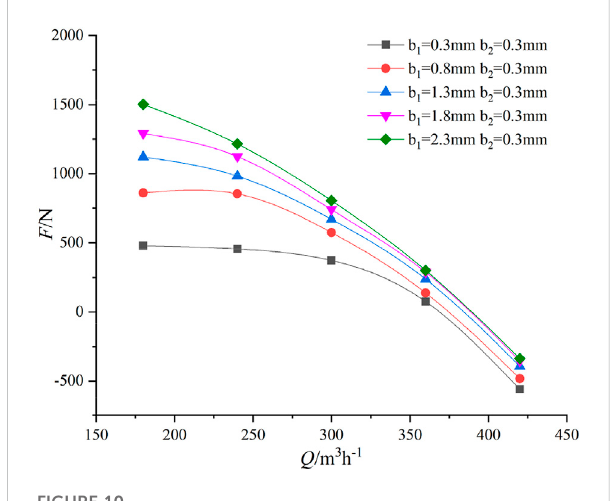
FIGURE 10 Axial force change of the CMP under different front wear-ring